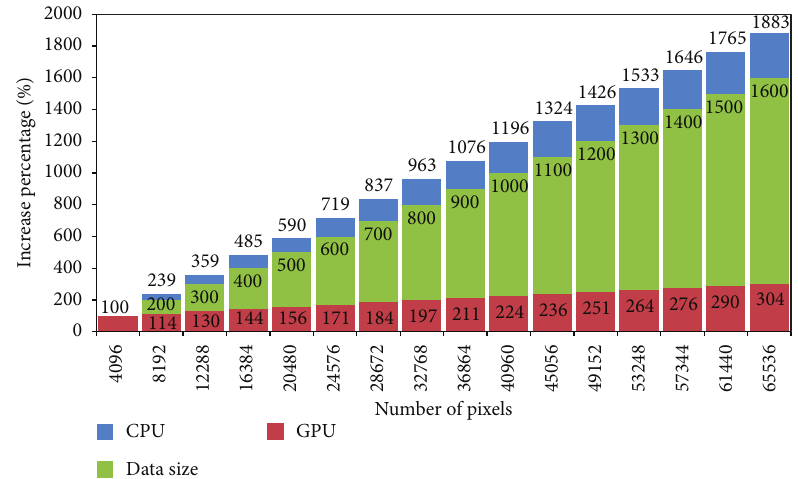
Figure 7: The growth speeds of the execution time of the CPU serial algorithm and the GPU parallel algorithm.